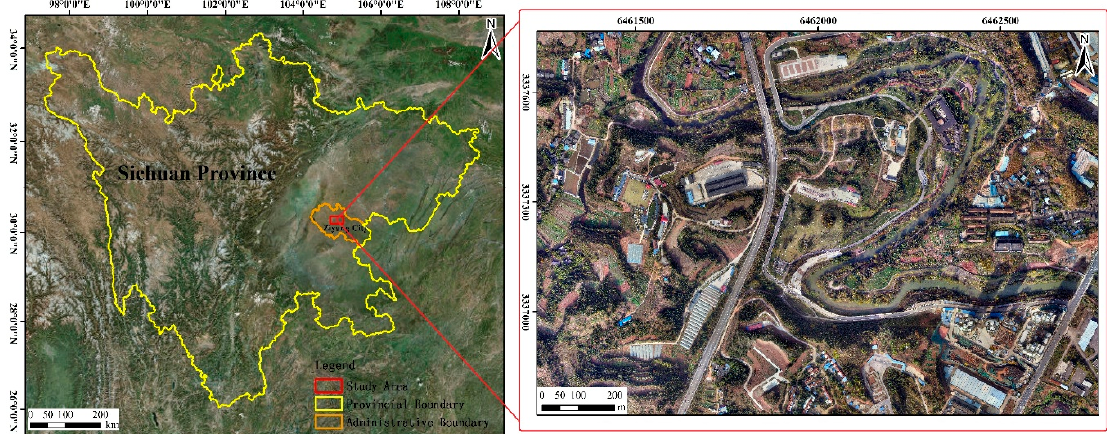
Figure 1. Location of study area.